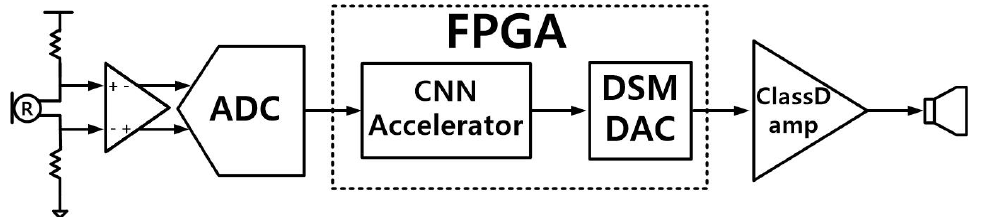
Figure 10. The proposed ANC system, using the hardware CNN